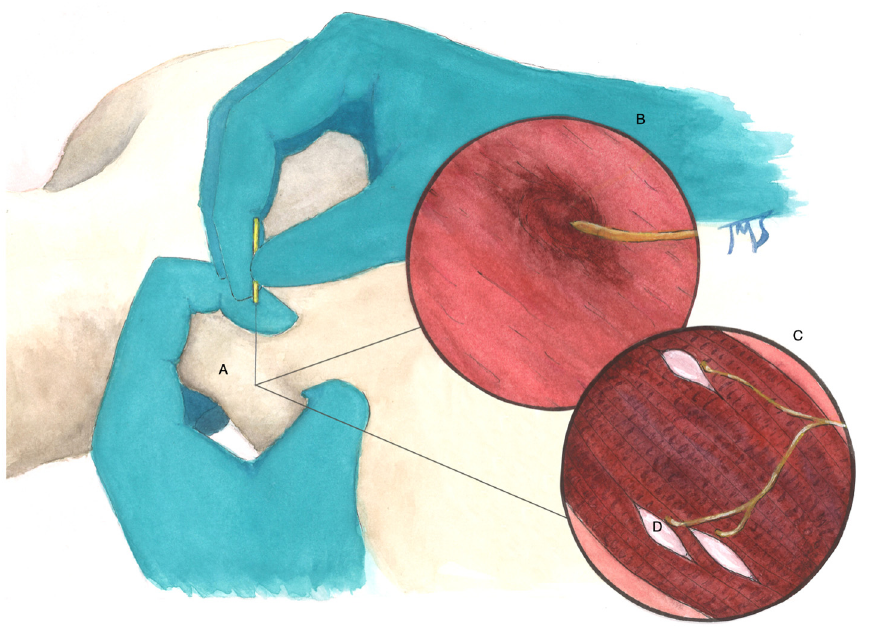
Figure 7. Illustration of the multiple loci hypothesis. ( A ) Palpable, tender nodule located within a taut band of skeletal muscle; ( B ) hyperperfused, hypoechoic contracture knot and nearby motor nerve; ( C ) multiple hypoperfused and hyperechoic trigger points located within a contracture knot; ( D ) region of multiple active loci (motor end plates) and sensitive loci (sensitized afferent nerve endings).